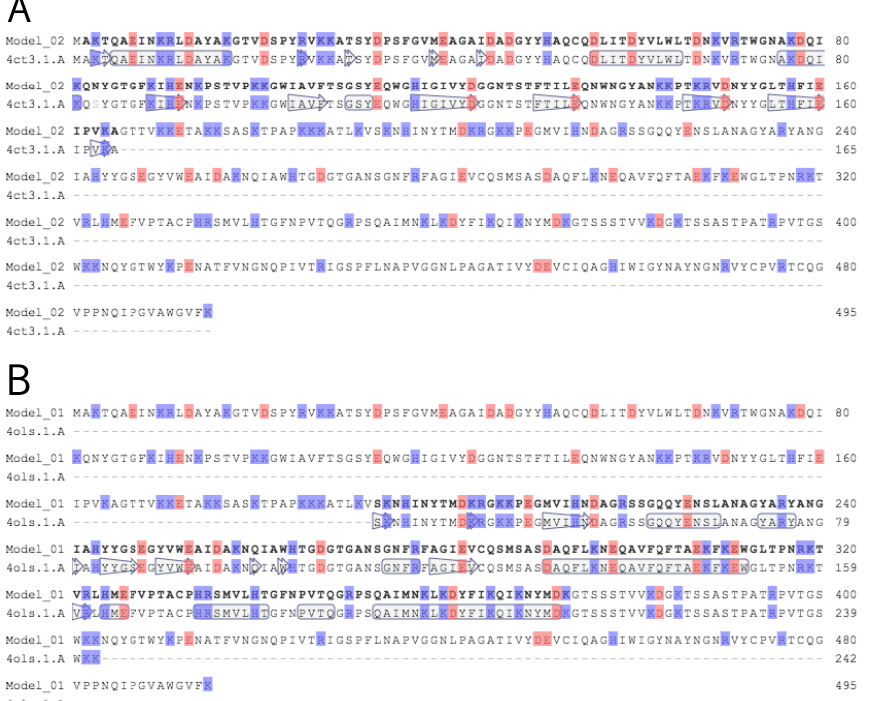
Figure A1. Model-template alignment in the protein structure model. Circles and arrows represent alpha-helices and beta-strands, respectively. Blue: positively charged amino acids, red: negatively charged amino acids. ( A ) Model-template alignment of the CHAP domain. Model_02; Lys-phiSA012 sequence. 4act. 1. A; Lys-phiK sequence. Lys-phiSA012 and Lys-phiK alignments of the other domains are described in Figure 1. ( B ) Model-template alignment of the AMID domain. Model_01; Lys-phiSA012 sequence. 4ols. 1. A; Lys-phiGH15 sequence. Lys-phiSA012 and Lys-phiGH15 alignments of the